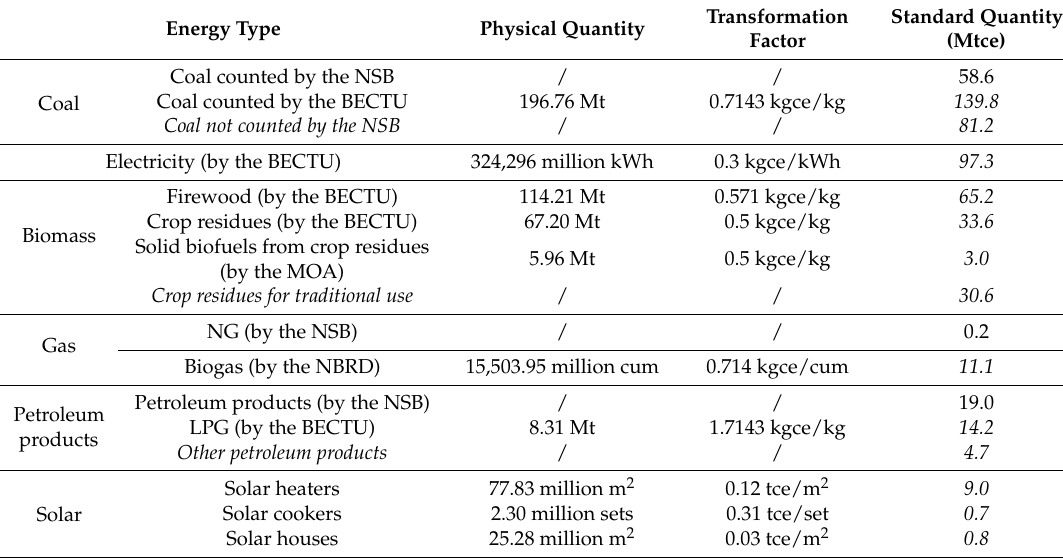
Table 3. Main energy types considered in the